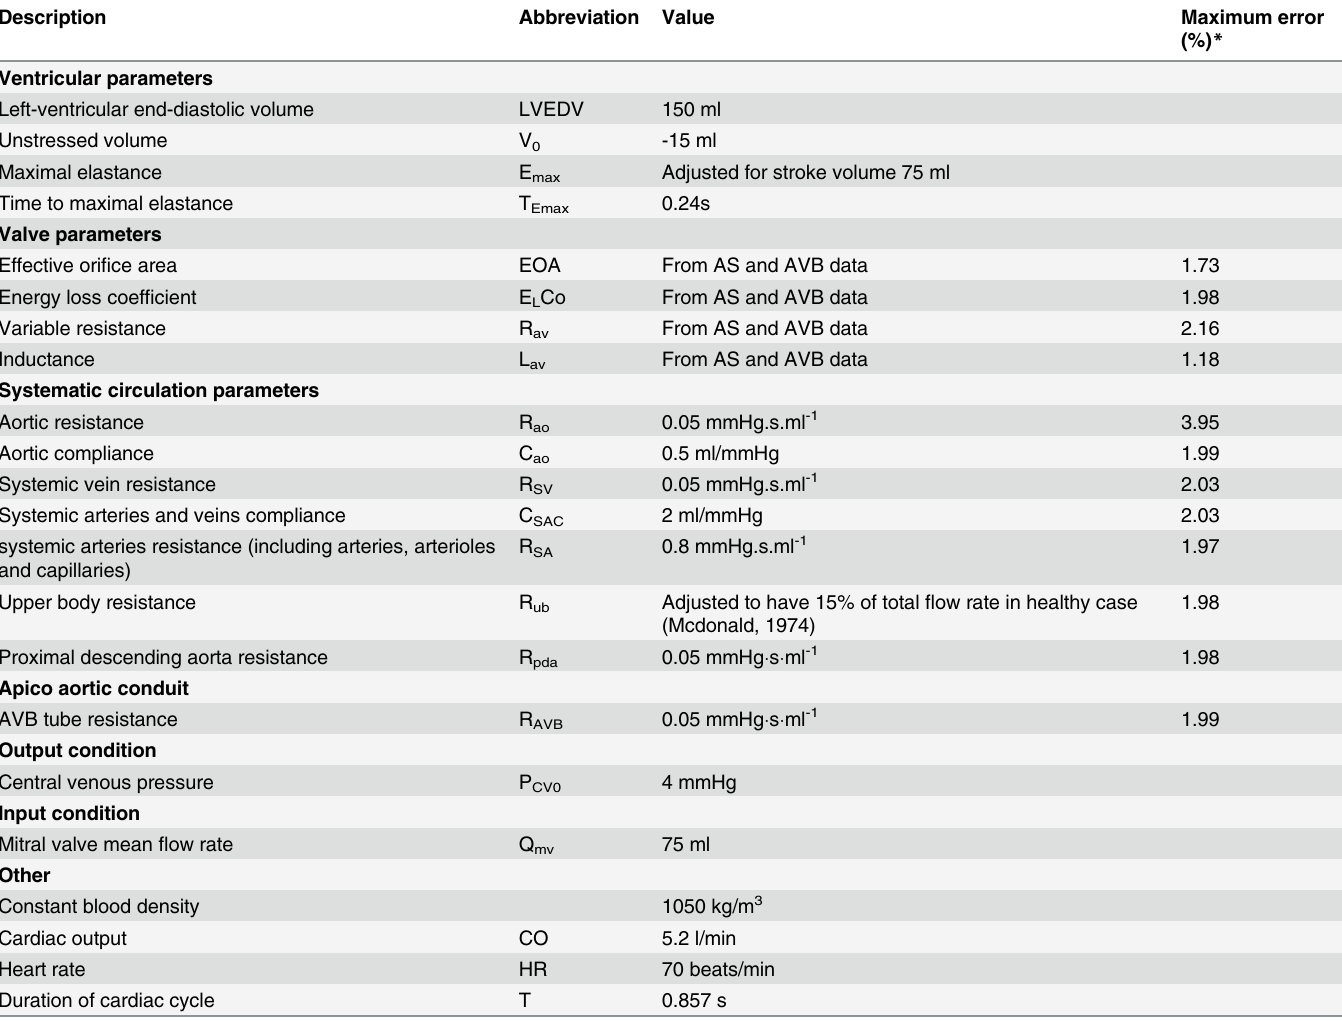
Table 1. Summarized cardiovascular parameters used to simulate all